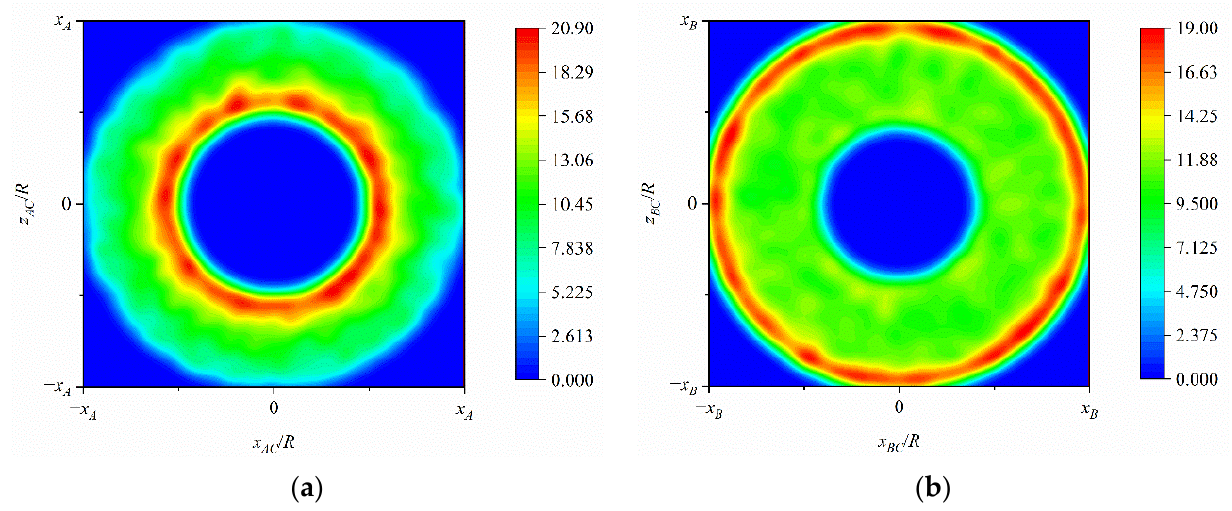
Figure 9. Energy distribution on photoelectric conversion system: ( a ) the first segment (curve AC ); ( b ) the second segment (curve CB ). Table 1. Detailed parameters of optimal design.